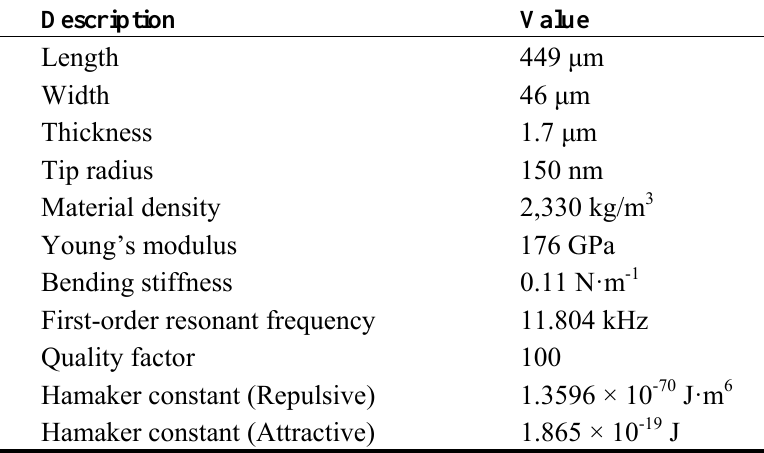
Table 1. Parameters of the silicon tip tapping and silicon sample used in the numerical